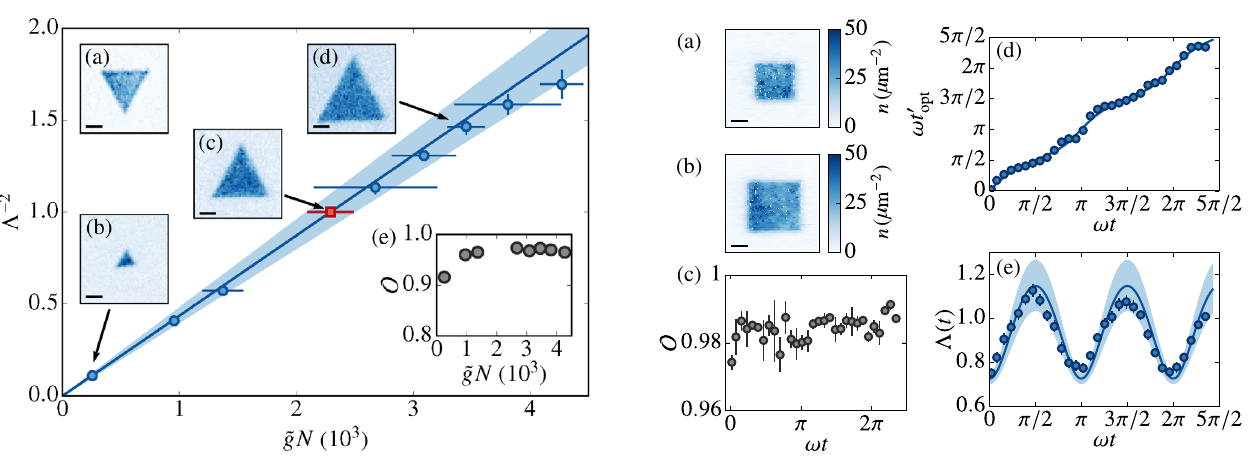
FIG. 4. Mapping between two clouds with the same shape, different sizes, and different atom numbers. (a),(b) Initial density distribution of the two clouds. The horizontal black lines represent 10 μ m. (c) Best overlap between each image of the first series of images and the images of the second one. (d) Optimal time t 0 of opt the second evolution as a function of the time t of the first evolution. (e) Optimal scaling factor Λ ð t Þ between the first and second evolutions. In (d) and (e), the solid lines are the predictions (25) and (24) where the values of the parameters α and μ are measured independently. The uncertainty of these values is represented as a shaded area. In (d), this area is too narrow to be discernable. In (c) – (e), the error bars indicate the confidence intervals within 2 standard deviations of the fit that we use to reconstruct the scaling laws. They are too small to be seen on